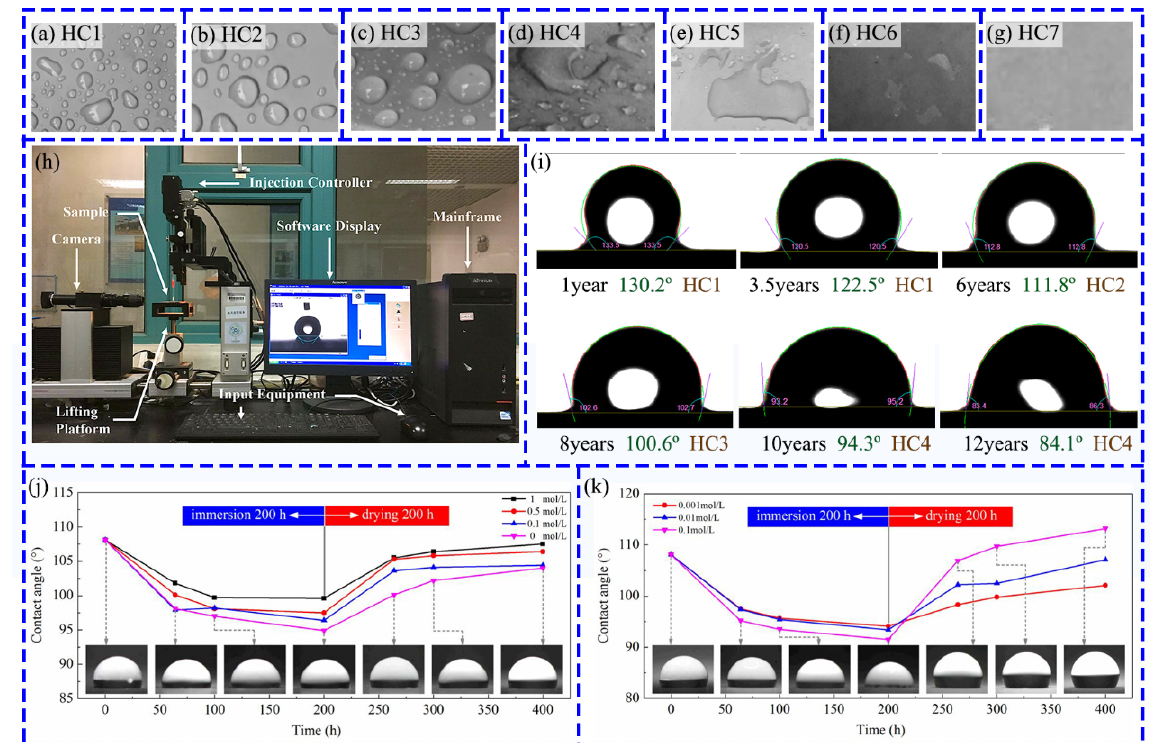
Figure 7. Detection of composite insulator aging by hydrophobic method. ( a – g ) Comparison dia- gram of water spray grade method droplets and hydrophobic grade. ( h ) Contact angle measuring instrument. ( i ) Contact angle and hydrophobic grade of composite insulators that have been used for 1–12 years. ( j ) Loss and recovery of hydrophobicity of samples during soaking and drying in NaCl solution. ( k ) Loss and recovery of hydrophobicity of samples during soaking and drying in nitric acid solution.